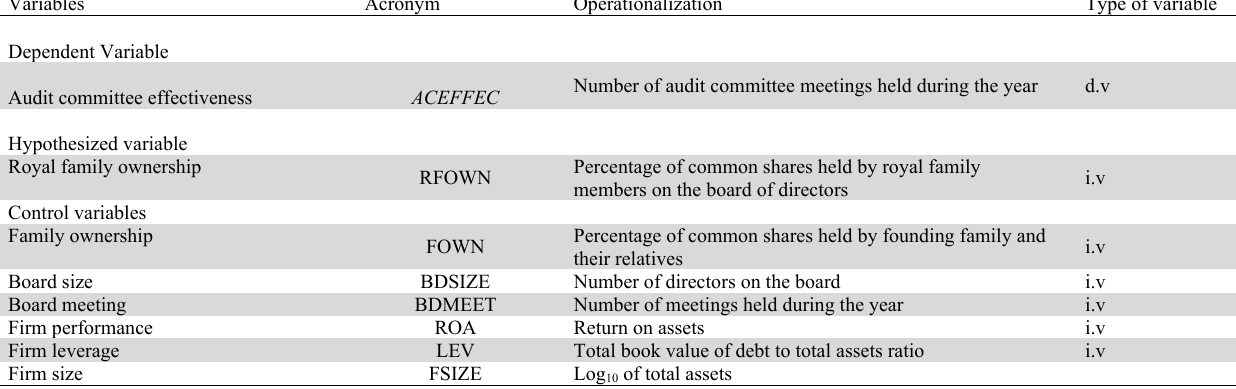
Summary of the Operationalization of the Research